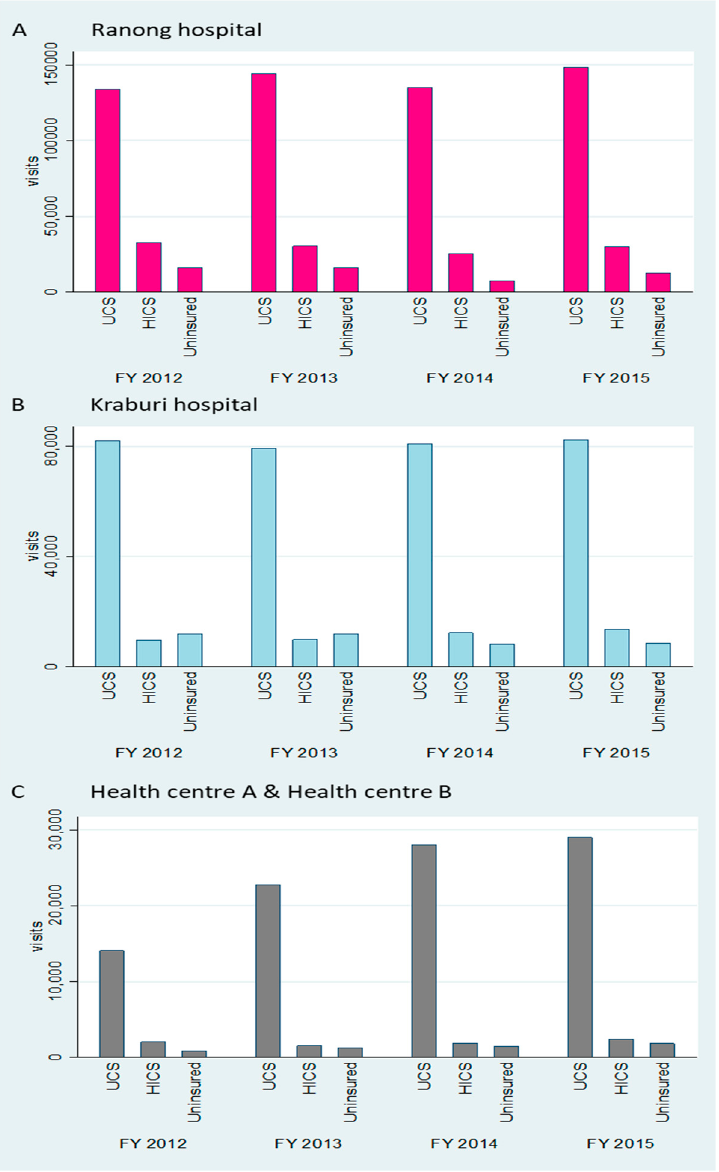
Figure 6. OP utilisation volume in Ranong Hospital ( A ), Kraburi Hospital ( B ), and Health Centres A and B ( C ) by the three most common insurance schemes across